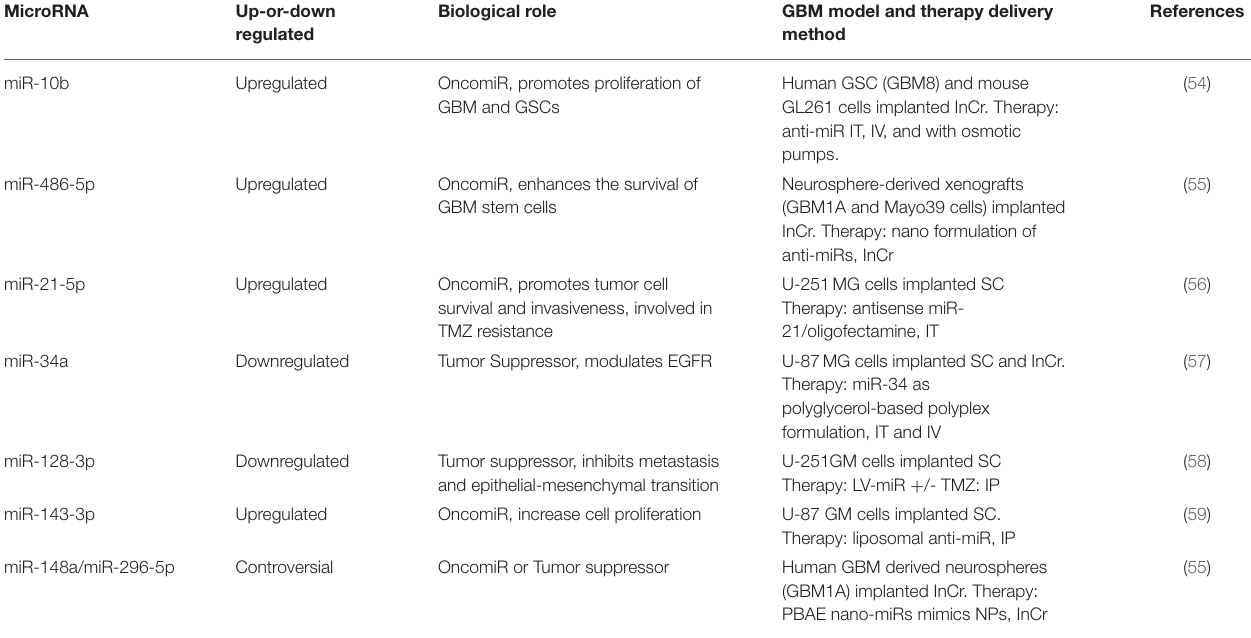
TABLE 1 | List of most relevant MiRNAs as potential targets against GBM.